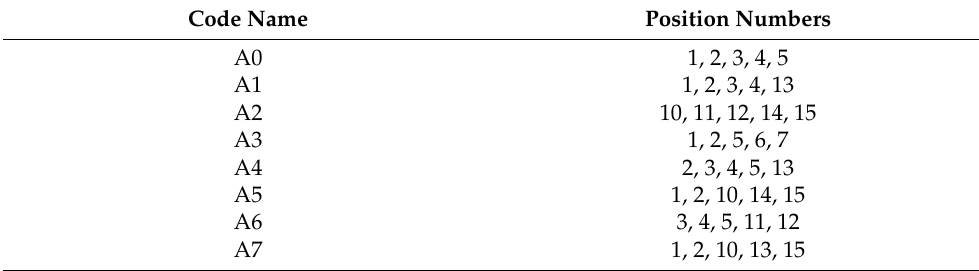
Table 3. Artificial sets of release